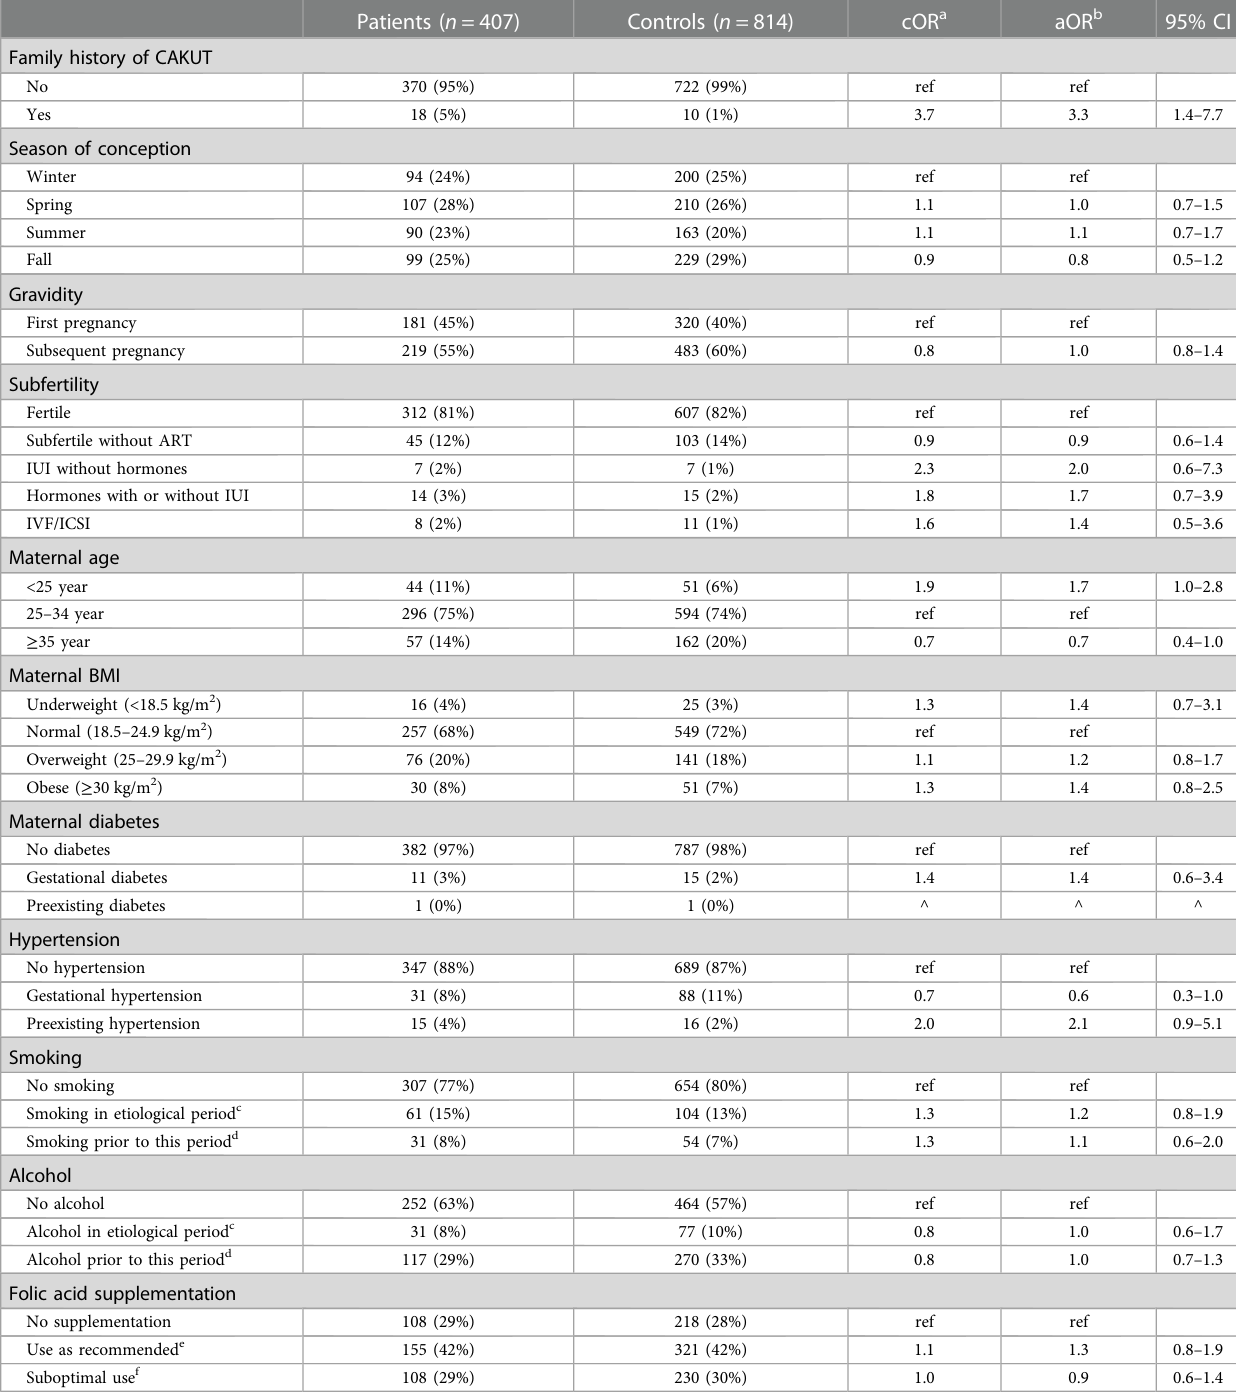
TABLE 2 Crude and adjusted odds ratios for the associations between potential risk factors and posterior urethral